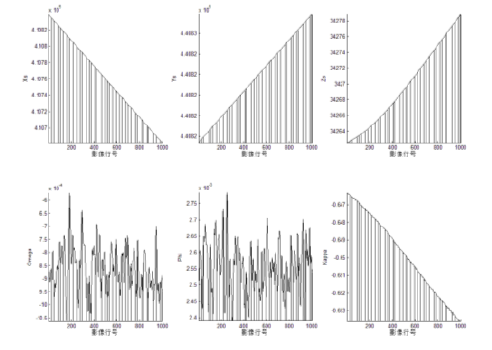
Figure 4. Unequal segment